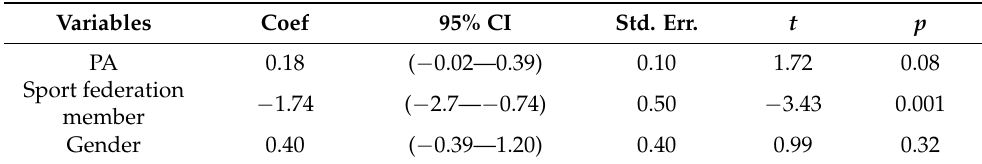
Table 3. Linear regression between problematic internet use and its associated variables. Adjusted by